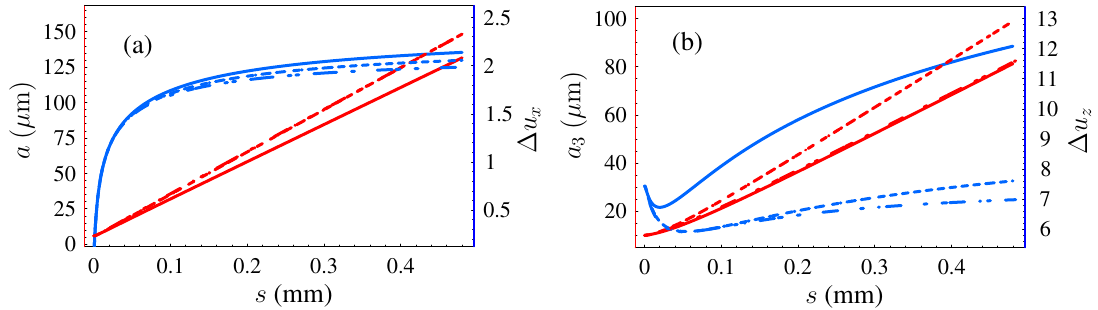
FIG. 11. (Color) Simulation of the space-charge blowup of typical beams produced by plasma accelerators in the self-modulated regime. Input parameters: Charge Q (cid:1) 5 nC , beam temperature k (cid:1) 2 mrad , typical distance between macroparticles n (cid:6) 1 = 3 gence x 0 max transverse radius a and transverse RMS momentum spread (cid:1) u as a function of propagation distance s is shown using the 3D-PPI model (solid), electrostatic PIC (dashed), and shell spread (cid:1) u z method (dot-dashed).